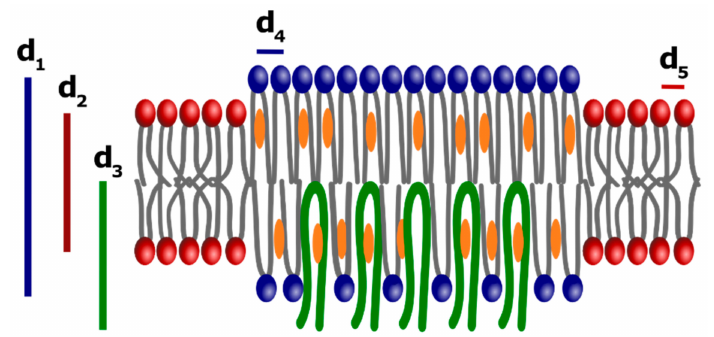
Figure 5. Schematic representation of the DRMs bilayer molecular organization. The body of our results, Langmuir isotherm and X-ray scattering experiments, suggest that an ordered phase made of saturated lipids (sphingolipids and gangliosides) and cholesterol is formed (blu), named “cholesterol-rich L o phase”, together with a more fluid L d phase made of unsaturated lipids (red). From X-ray scattering results, d 1 = 57.2 and d 4 = 4.2 Å could be associated with the “cholesterol-rich L o phase”. A less ordered L d phase, characterized by d 2 = 39.9 and d 5 = 3 Å, is also present. Both phases are typical of the lipid-rafts and are present even in the absence of Cav-1 (KO-DRMs). In the presence of Cav-1 a “caveolin-induced L o phase” can be formed, embedded in the first and characterized by d 3 = 34 and d 4 = 4.2